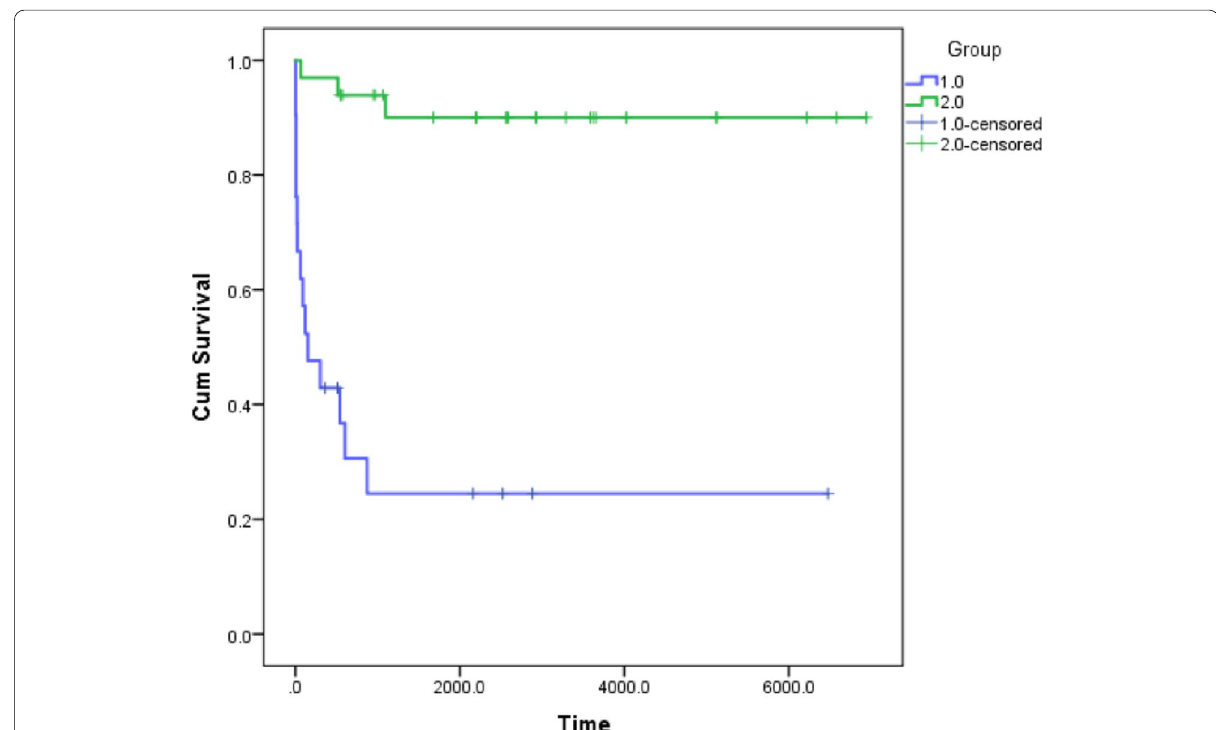
Fig. 1 Cumulative survival plot for all patients